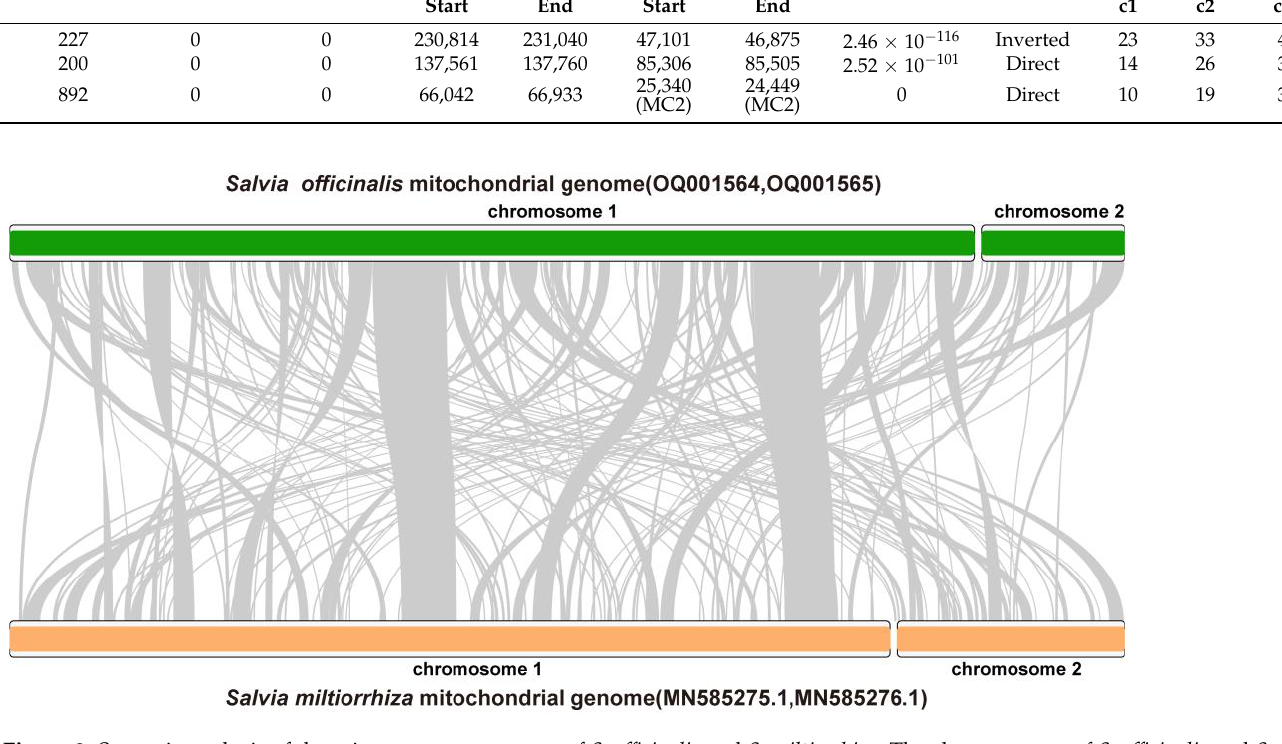
Figure 3. Syntenic analysis of the mitogenome sequences of S. officinalis and S. miltiorrhiza . The chromosomes of S. officinalis and S. miltiorrhiza are shown with green and orange blocks, respectively. DNA fragments having a similarity > 85% were connected with gray lines.